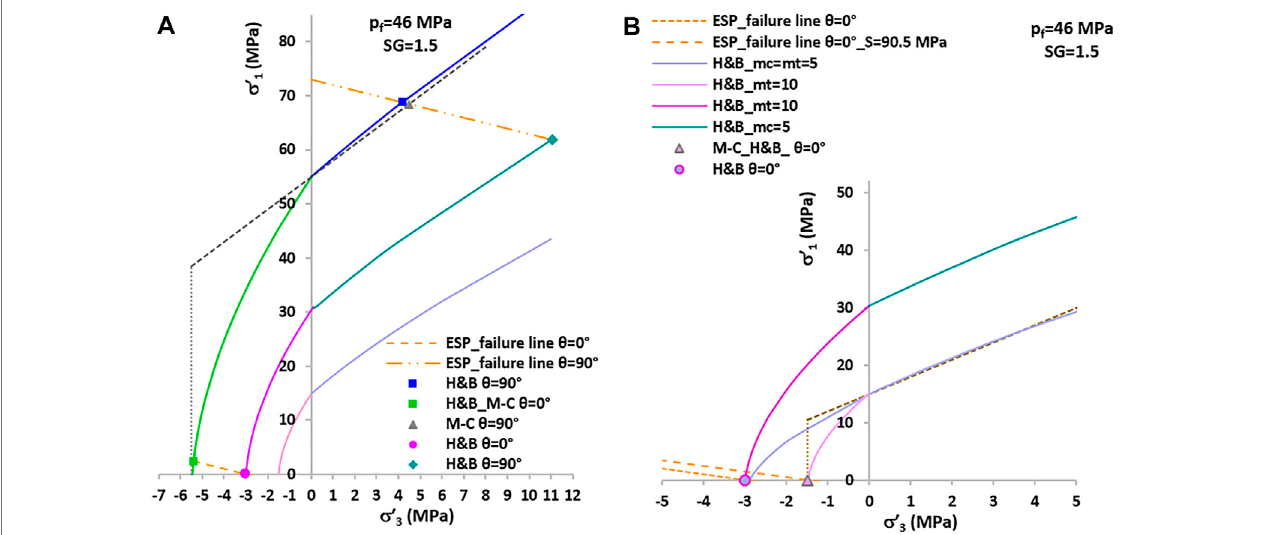
FIGURE 15 | Strength envelopes of the shale and limit failure condition with H&B and M-C criterion, points at failure and ESP failure lines. p f = 46 MPa. (A) Parameters of the H&B criterion: σ c = 15-30.3-55 MPa, m c = 5, m t = 10, and σ c / σ t ≈ 10; parameters of the M-C criterion: σ c = 30 MPa, σ c / σ t ≈ 10, and ϕ ′ = 30 ° .